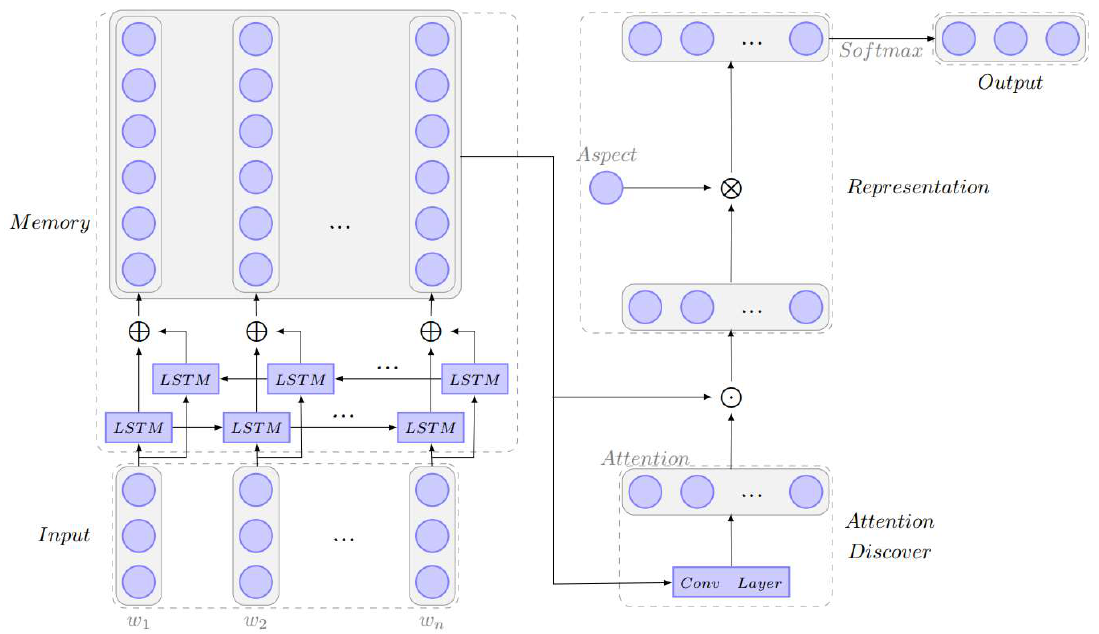
Figure 1. The architecture of AARCNN.